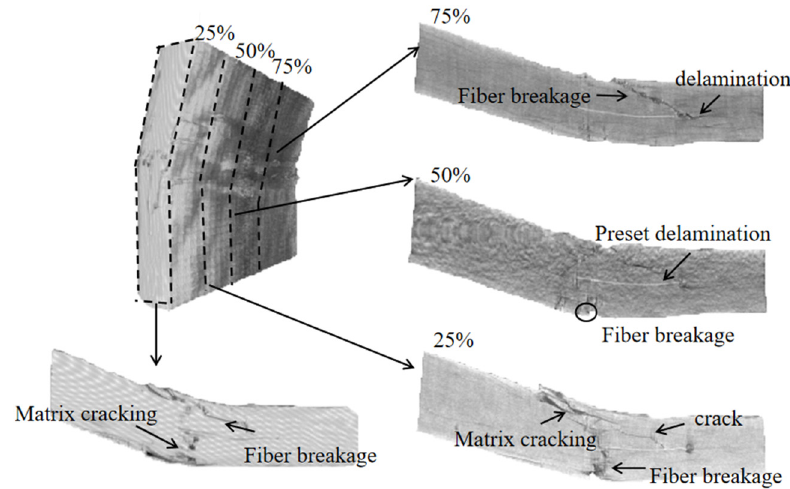
Figure 14: Micro - CT images of failure modes of specimen D at 25, 50, and 75% cross sections in the width